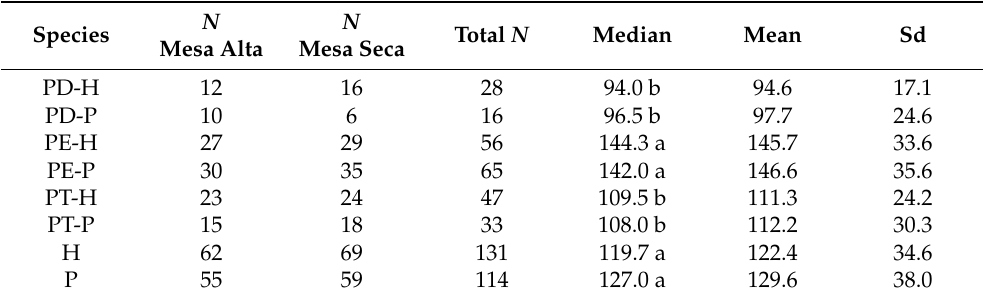
Table 6. Descriptive statistics of the estimated stomatal density (stomata/mm 2 ) for each pure species analyzed and the hybrids in both provenance trials.